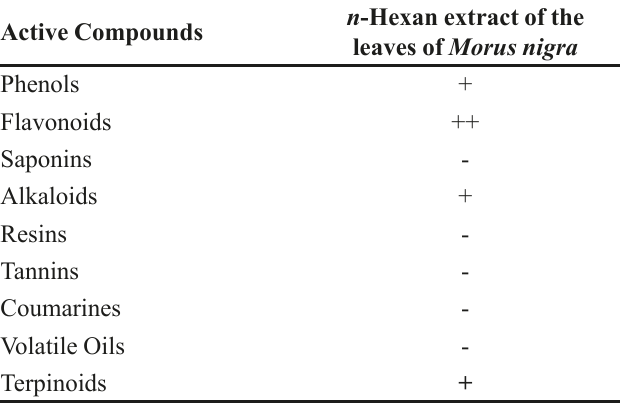
TABLE II - Phytochemical screening of n -hexan extract of the leaves of Morus nigra